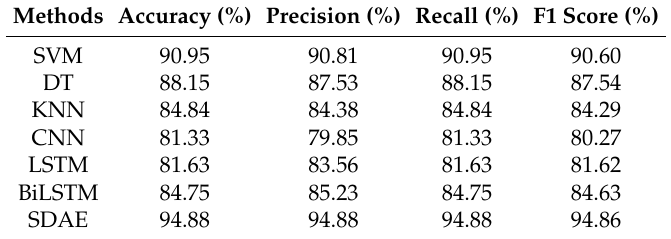
Table 8. Performance comparison between SDAE and other